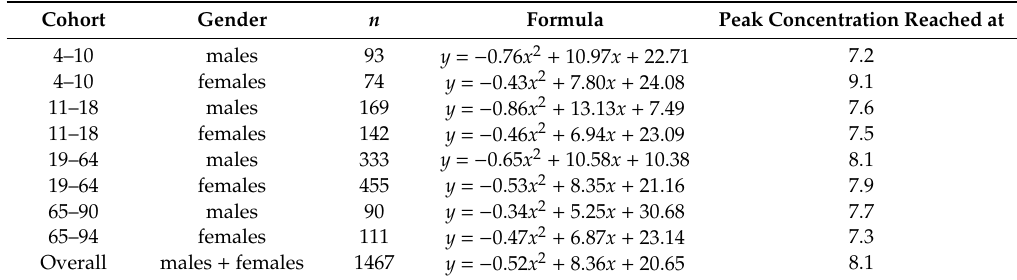
Table 4. Relationship between month of the year ( x ) and serum concentrations of 25(OH)D ( y in nmol / L), stating the month as an integer. January: 1, February: 2, etc. The time of the year at which the highest concentration of 25(OH)D in serum is found, is expressed as month in the year. Mathematical modeling on the data from the NDNS database.